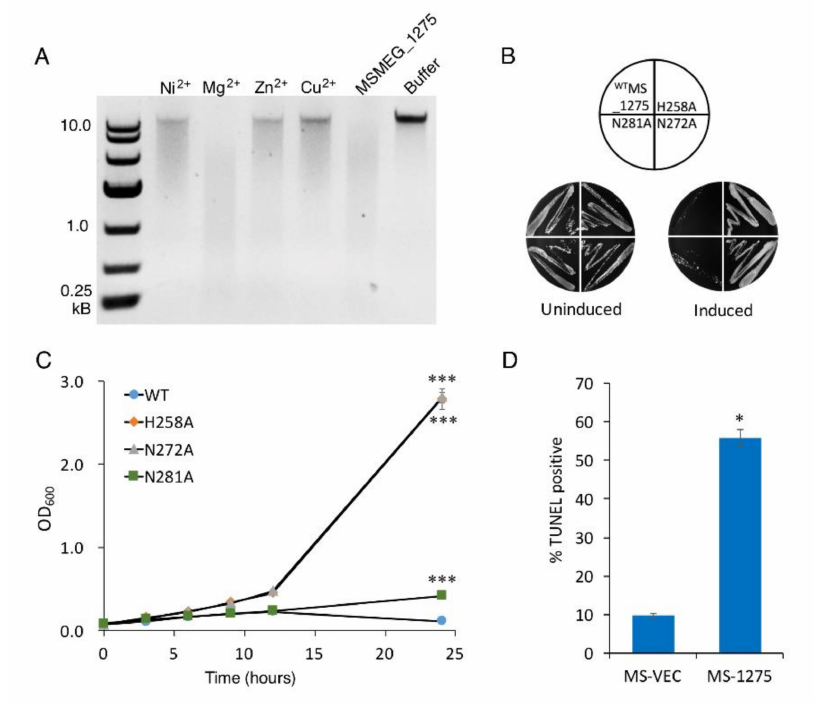
Figure 5. MSMEG_1275 is an HNH nuclease and cleaves double-stranded DNA of M. smegmatis . ( A ) Effect of divalent cations on the DNase activity. Toxicity results of single-site mutagenesis of 258H, 272N and 281N of MSMEG_1275 in solid ( B ) and liquid medium ( C ). ( D ) The percentage of TUNEL-positive of MS-VEC and MS-1275 after 12 h induction. Data are represented as mean +/ − SEM. Significance of mutant strains compared to MS-1275 WT strain was determined using a Student’s t test: * p < 0.05 and *** p <